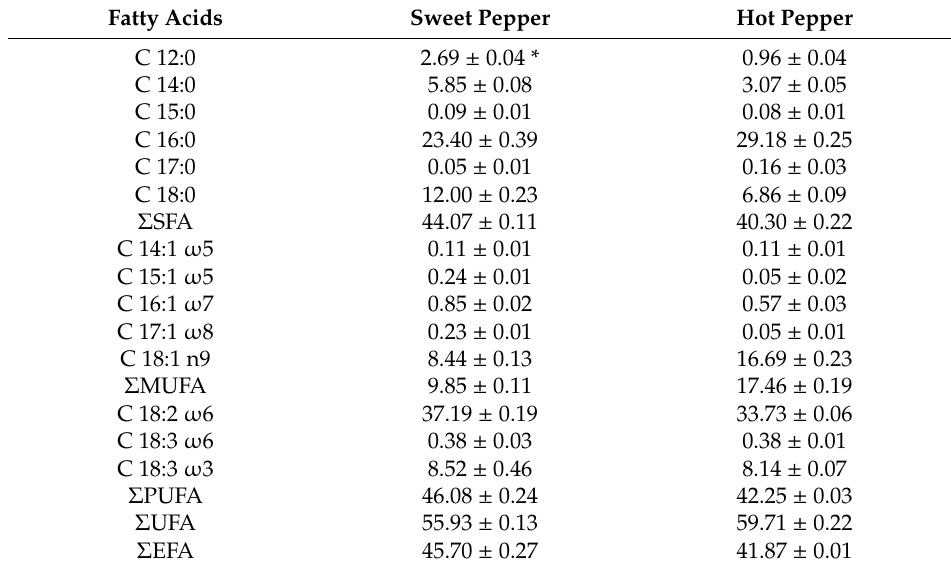
Table 5. Fatty acids composition for hot and sweet peppers from Altino (%). Fatty